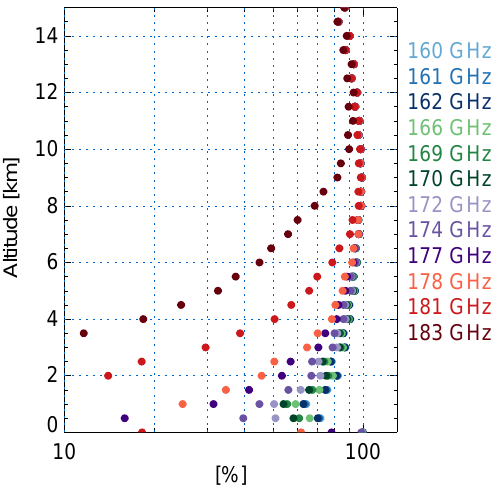
Figure 4. Percentage penetration for frequencies discussed in this study calculated using CloudSat-driven simulations for 10 days, as- suming a radar sensitivity of − 30dBZ.